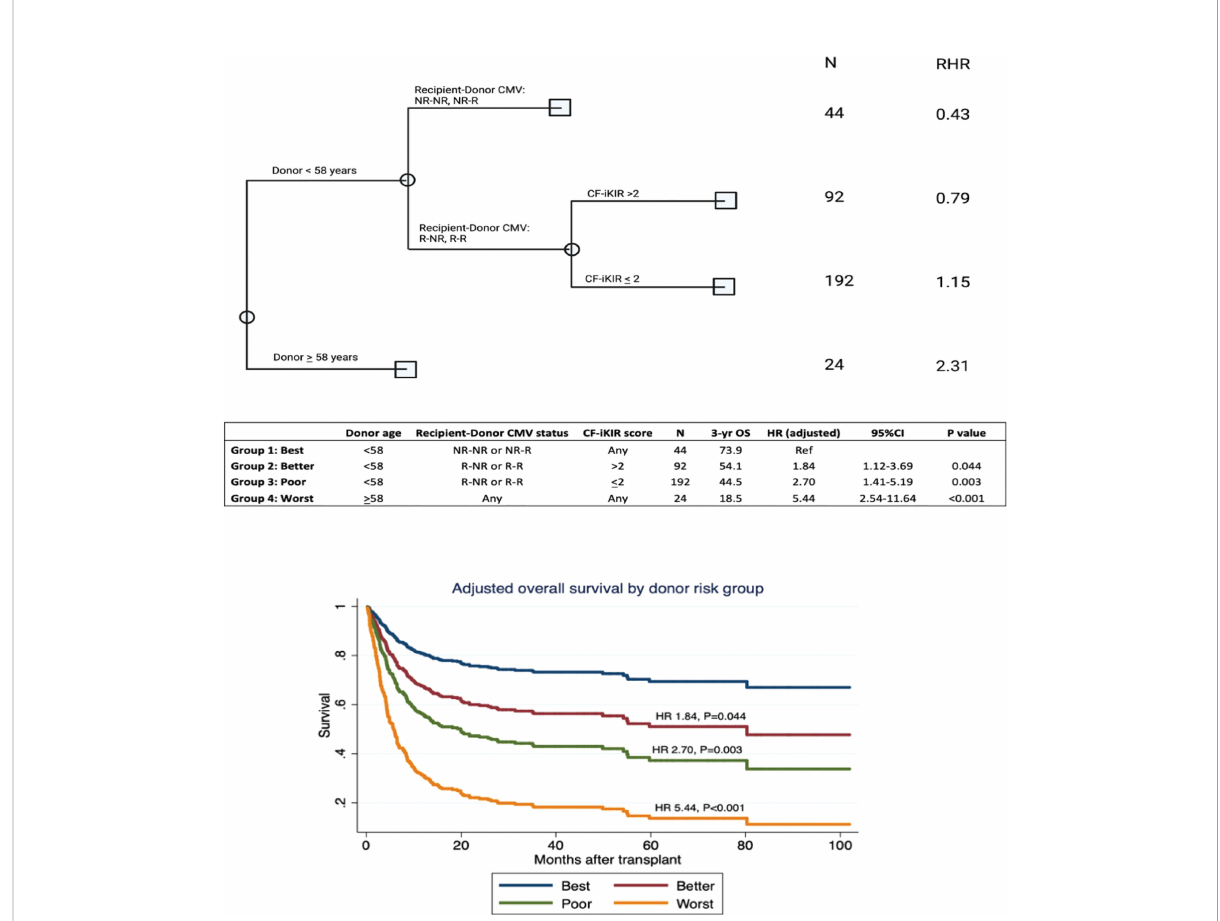
FIGURE 3 Algorithm for donor selection based on donor characteristics and natural killer cell alloreactivity predicted by CF-iKIR score. Abbreviations: CF- iKIR score, count functional inhibitory killer cell immunoglobulin-like receptor score; CMV, cytomegalovirus; NR, nonreactive; R, reactive; N, number; RHR, relative hazard ratio; OS, overall survival; HR, hazard ratio; CI, con fi dence